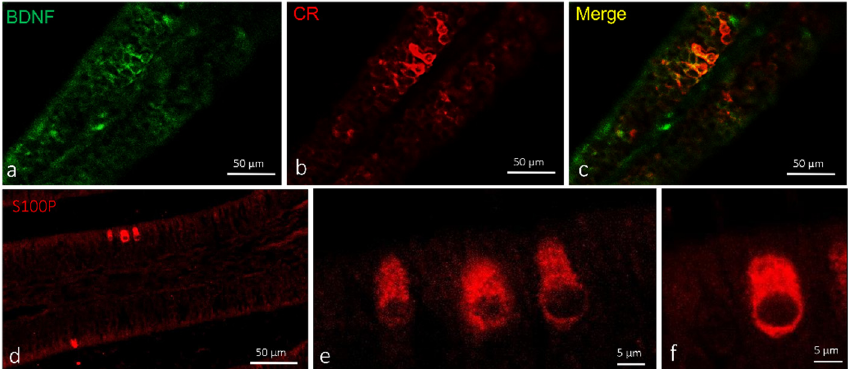
Figure 4. Olfactory lamellae of adult zebrafish, dorsal view. ( a – c ) Immunohistochemical detection (immunofluorescence method) of BDNF and calretinin. ( d – f ) Immunohistochemical detection (immunofluorescence method) of S100 protein. Ciliated sensory olfactory neurons in sensory segment of olfactory lamellae showing immunoreactivity to ( a ) BDNF and ( b ) calretinin. ( c ) Colocalization view ( d – f ). Crypt olfactory neurons showing immunoreactivity to S100 protein. Scale bar ( a – d ) 50 µm and ( e , f ) 5 µm.